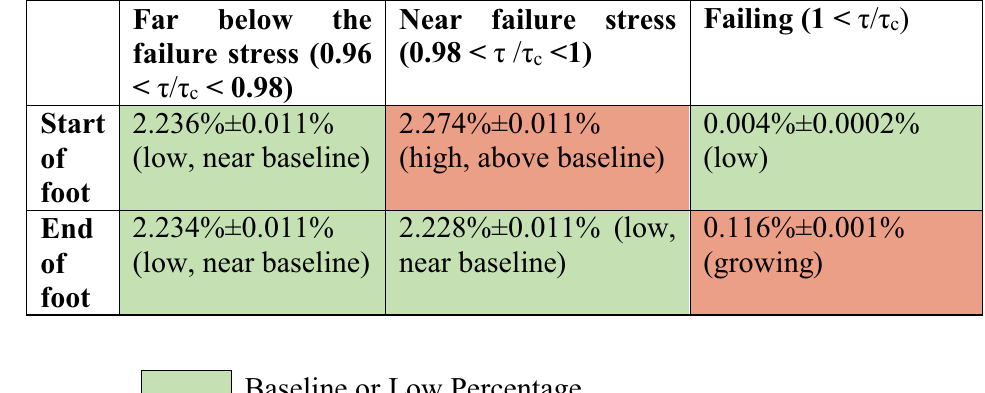
Table 1. Percentage of cells at various normalized stress levels τ/τ c before and after the avalanche foot (which is the time during which the nucleus of the large avalanche reaches the critical size to initiate a system-spanning event). All measured events occur after all transients from the initial conditions have subsided. Confidence intervals for the error bars are 2σ. System size = 100,000 cells, weakening = 0.007, stress conservation parameter (see SI and 5 ) c = 0.997, number of time steps = 100,000. The baseline is defined as 2.23%. The table illustrates how a stress concentration (i.e. an unusually high number of cells synchronized near the local failure stress) can result in the nucleation of a large event. Note that for any cell, τ/τ c can jump in one discrete time step from τ/ τ c < 1 to τ /τ c > 1 and vice